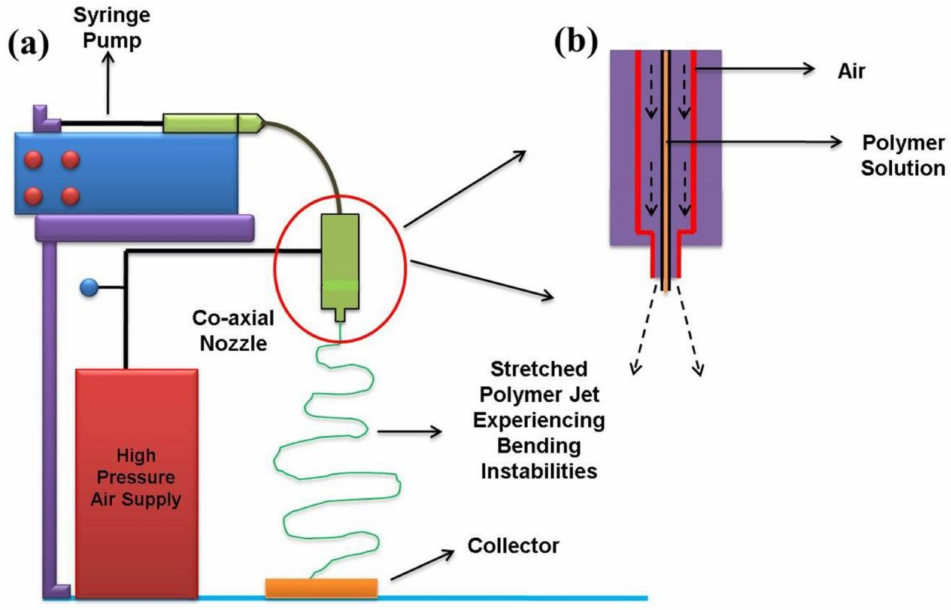
Figure 3. Schematic representation of solution blowing: ( a ) The overall view and ( b ) the zoomed in view of the solution blowing co-axial